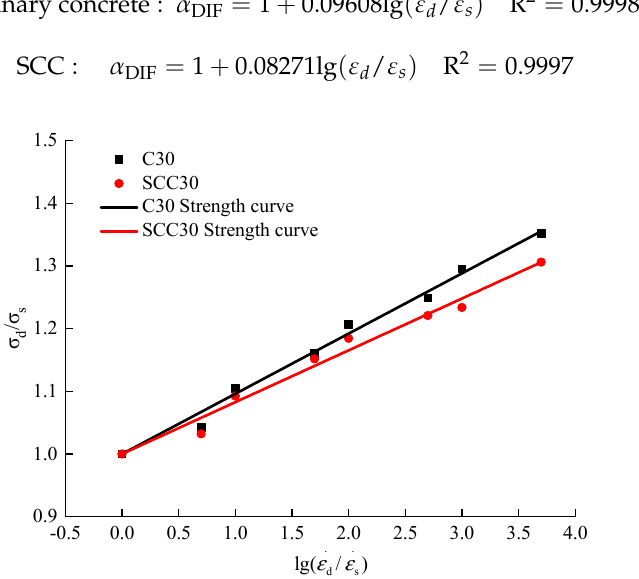
Figure 9. Relationship between strain rate and dynamic increase coefficient of peak stress.